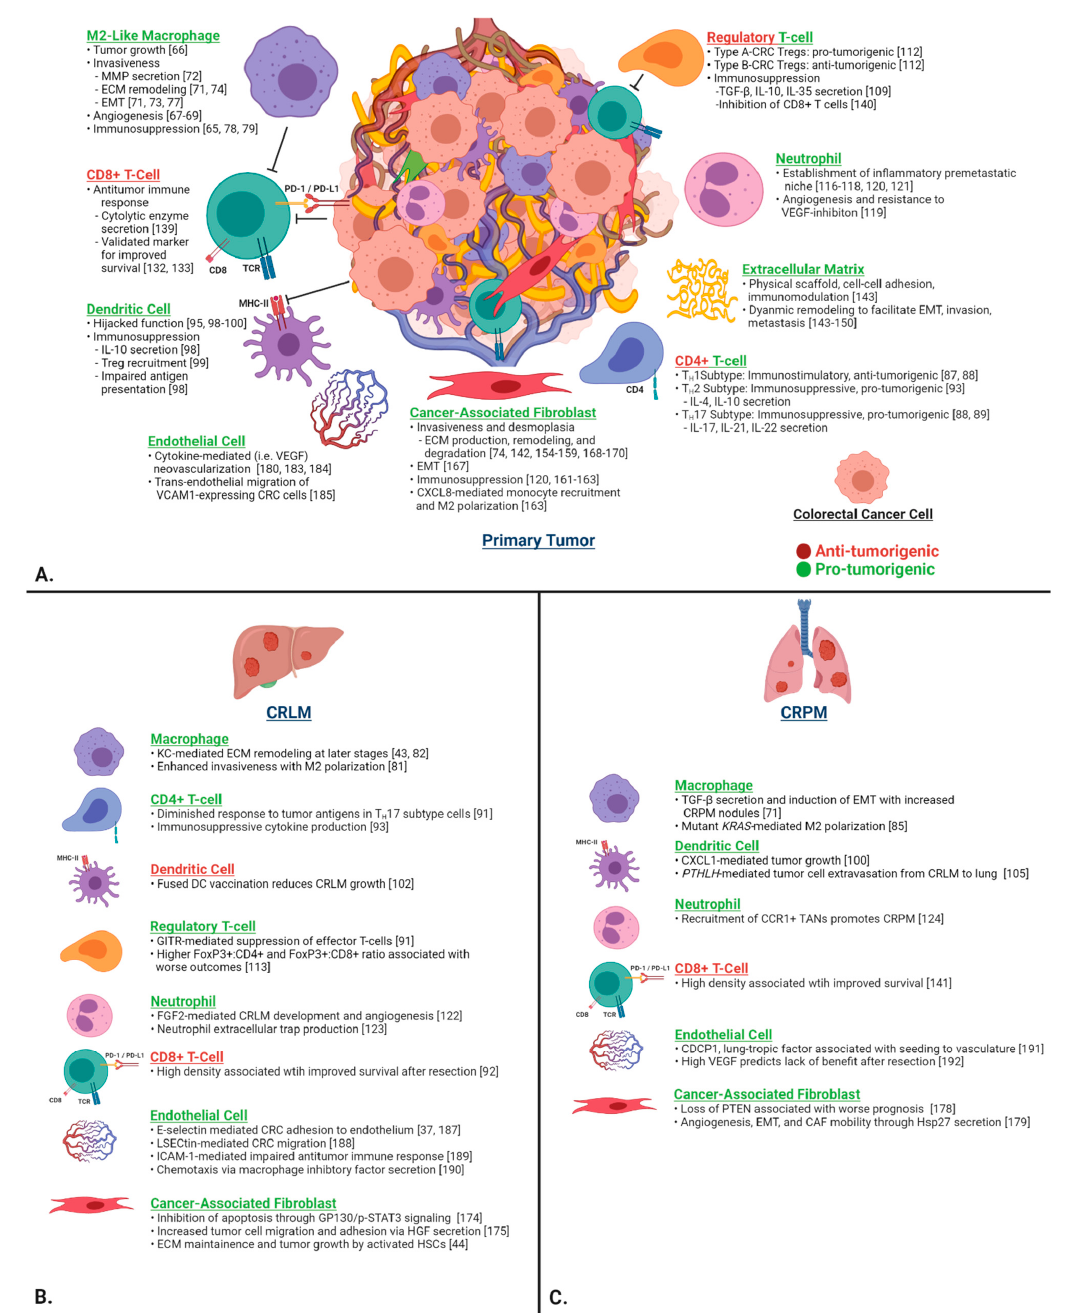
Figure 2. ( A ) Contributions of the key individual components of the CRC TME on tumor progression, invasion, ECM remodeling, immunosuppression, and metastasis in the primary tumor. ( B ) CRLM- and ( C ) CRPM-specific functions are depicted in the lower two panels. Green headings signify pro-tumorigenic functions, and red headings signify anti-tumorigenic functions. Abbreviations: CRC, colorectal cancer; ECM, extracellular matrix; EMT, epithelial–mesenchymal transition; MMP, matrix metalloproteinase; TME, tumor microenvironment.